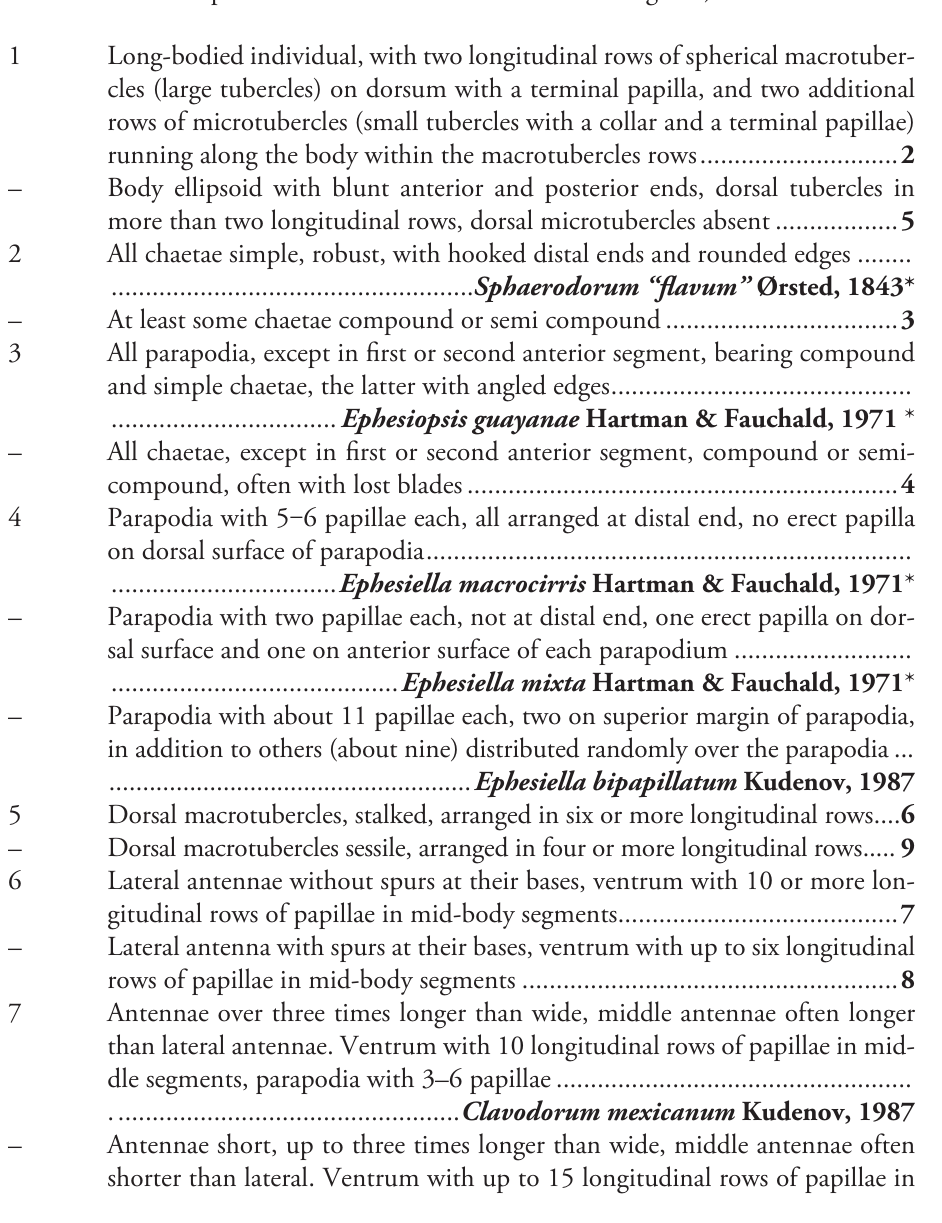
– Antennae short, up to three times longer than wide, middle antennae often shorter than lateral. Ventrum with up to 15 longitudinal rows of papillae